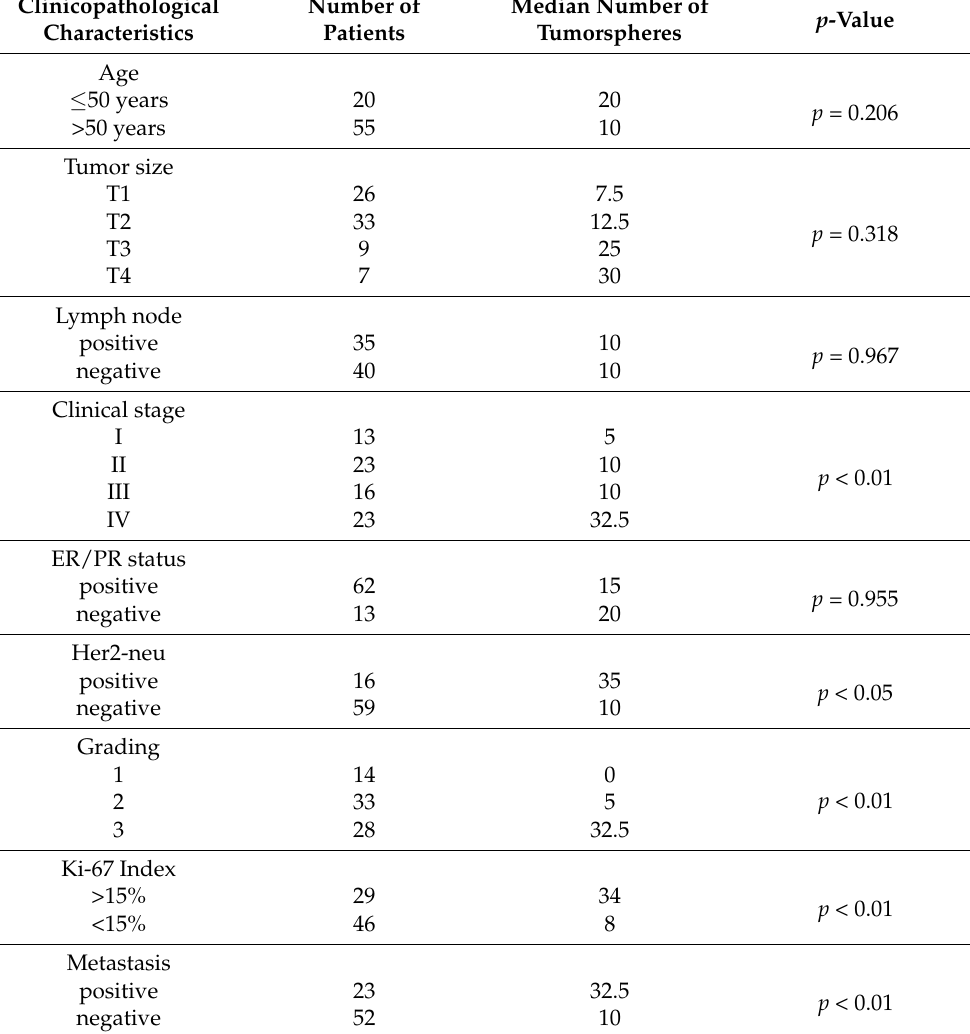
Table 1. Clinicopathological parameters of patients with breast